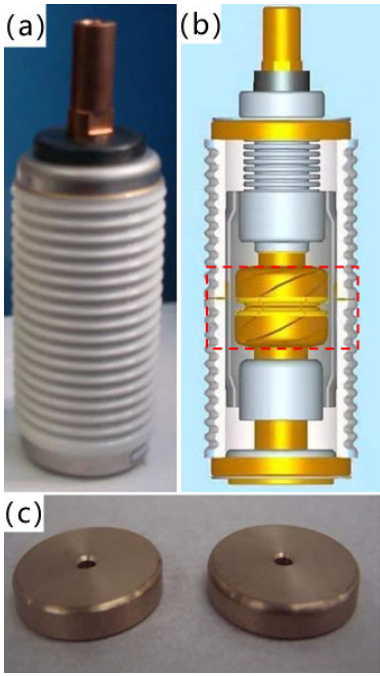
Fig. 9 (a) Photograph of a high power vacuum switch; (b) profile of the vacuum switch: the static and moving contacts are marked with a dashed rectangle; (c) Ti 3 SiC 2 /Cu vacuum contact materials. Reproduced with permission from Ref. [107], © The Author(s) 2008